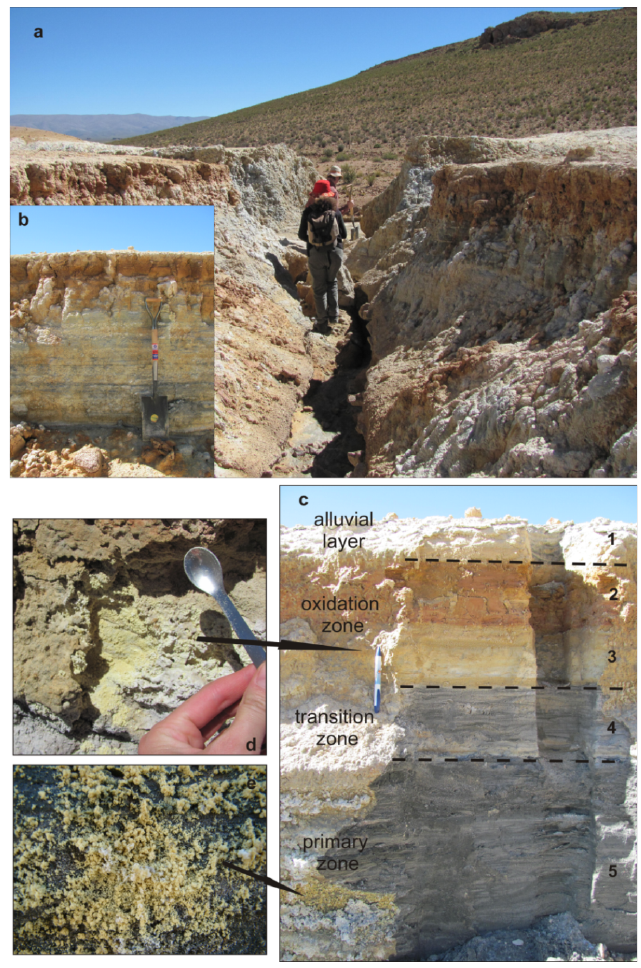
Figure 2. Tailings impoundment DC2. ( a ) Picture of the erosion channel originated by fluvial erosion during the rainy season; ( b ) Wall of the erosion channel where a profile of the tailings covered by efflorescent salts is visible; ( c ) Profile DC2-P2 (1.11 m depth) after cleaning its surface, 1 = DC2-P2-1; 2 = DC2-P2-2; 3 = DC2-P2-3; 4 = DC2-P2-4; 5 = DC2-P2-5; ( d ) Yellow efflorescent salts sampled in the oxidation zone (sample DC2-P2-3-E); and ( e ) Yellow and white efflorescent salts sampled in the primary zone (sample